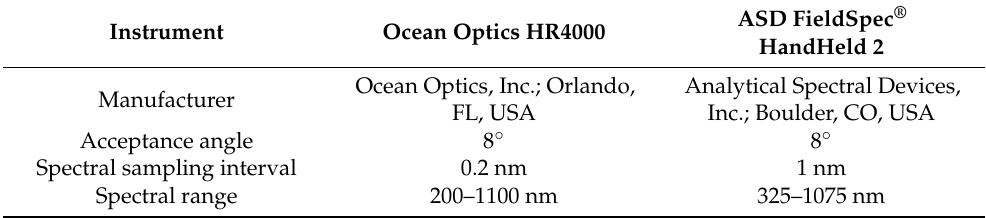
Table 2. Spectroradiometer